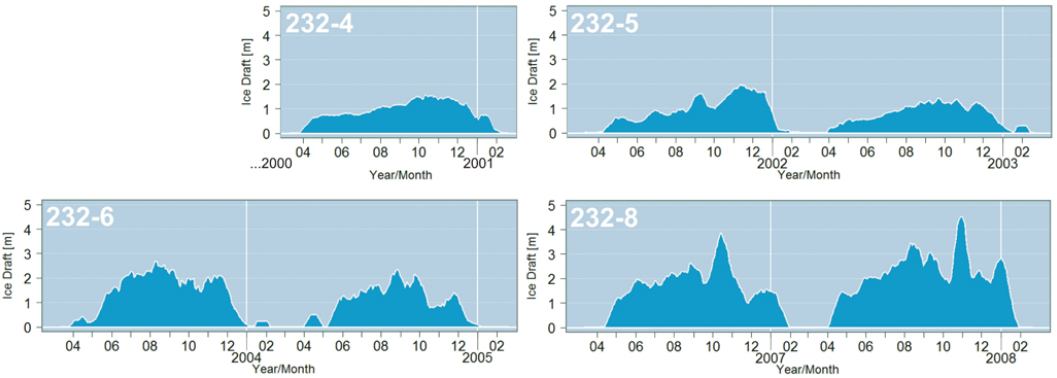
Figure 14. Same as in Fig. 13, but for sea ice draft at the position AWI-232 in the years 2000 (AWI 232-4), 2001–2002 (AWI 232-5), 2003–2004 (AWI 232-6) and 2006–2008 (AWI